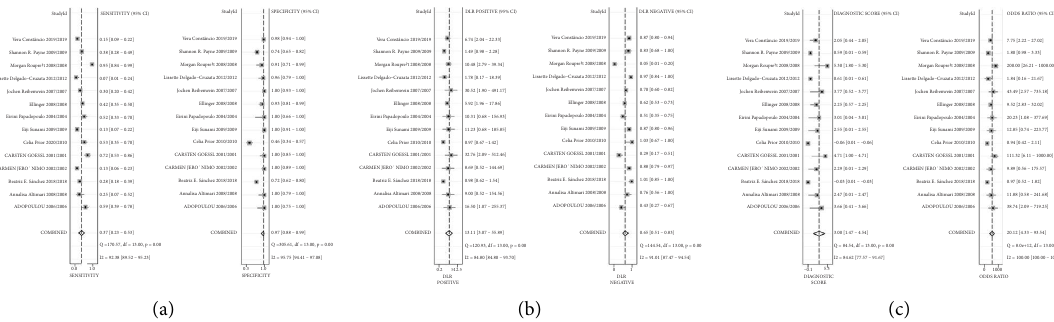
Figure 2: Diagnostic value of GSTP1 methylation in PCa. (a) Forest plots for sensitivity and specifcity. (b) Forest plots for PLR and NLR. (c) Forest plots for DOR. (PLR: positive likelihood ratio; NLR: negative likelihood ratio; DOR: diagnostic odds